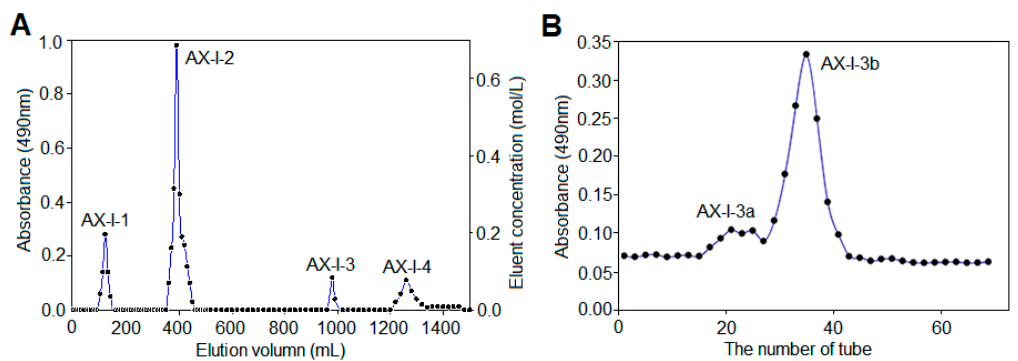
Figure 1. Chromatography of AX-I-3b on DEAE-cellulose 52 Column ( A ) and on SepHacryl S-400 HR gel column ( B ).